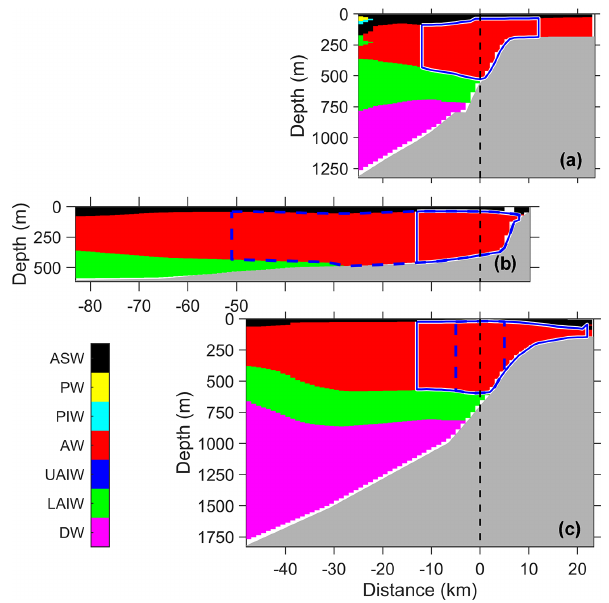
Figure 3. Distribution of water masses for sections (a) A, (b) B and (c) C. Other details are as in Fig. 2. The different water masses are listed in Table